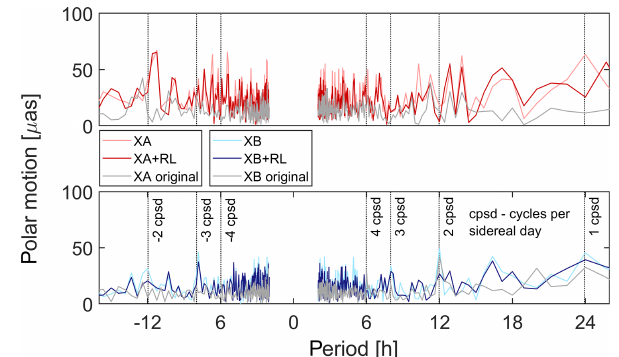
Figure 6. Amplitude spectra of polar motion variations.